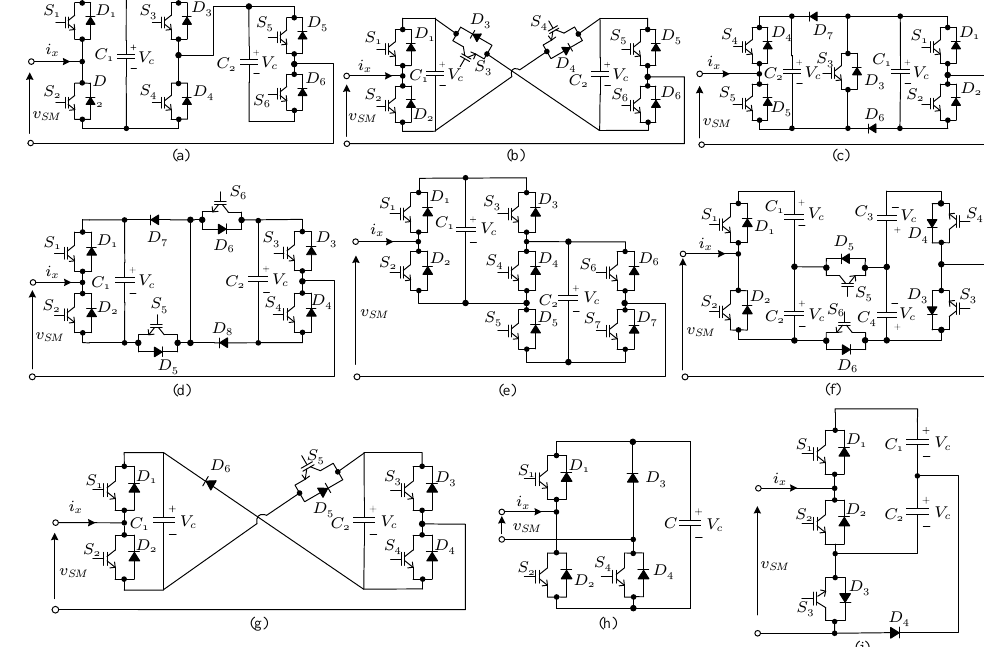
Figure 5. Bipolar SMs: ( a ) Mix-SM—Mix-connected SM; ( b ) CCSM—Cross-connected SM; ( c ) CD- SM—Clamped-double SM; ( d ) 3L-CDSM—Three-level clamped-double SM; ( e ) SFB-SM—Semi-full- bridge SM; ( f ) AFB-CCDSM—Cross-Connected Asymmetrical Full Bridge SM; ( g ) 3L-CCSM—Three- level cross-connected SM; ( h ) UFBSM—“Unipolar-voltage” full-bridge SM; and ( i ) SC-SM—Single- clamped